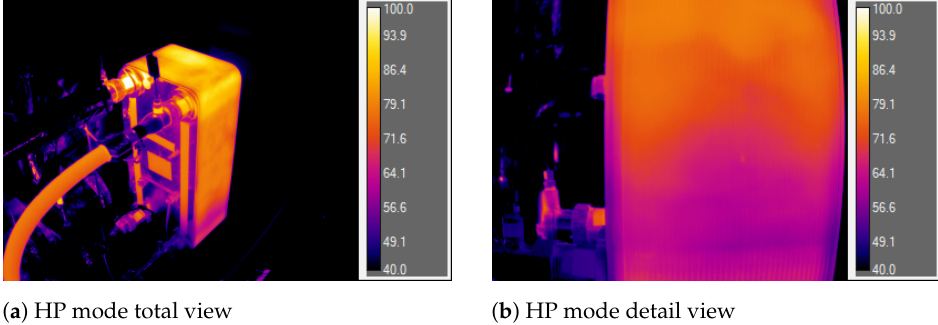
Figure 6. TIC images of the reversible heat exchanger during operation as an HP-condenser.